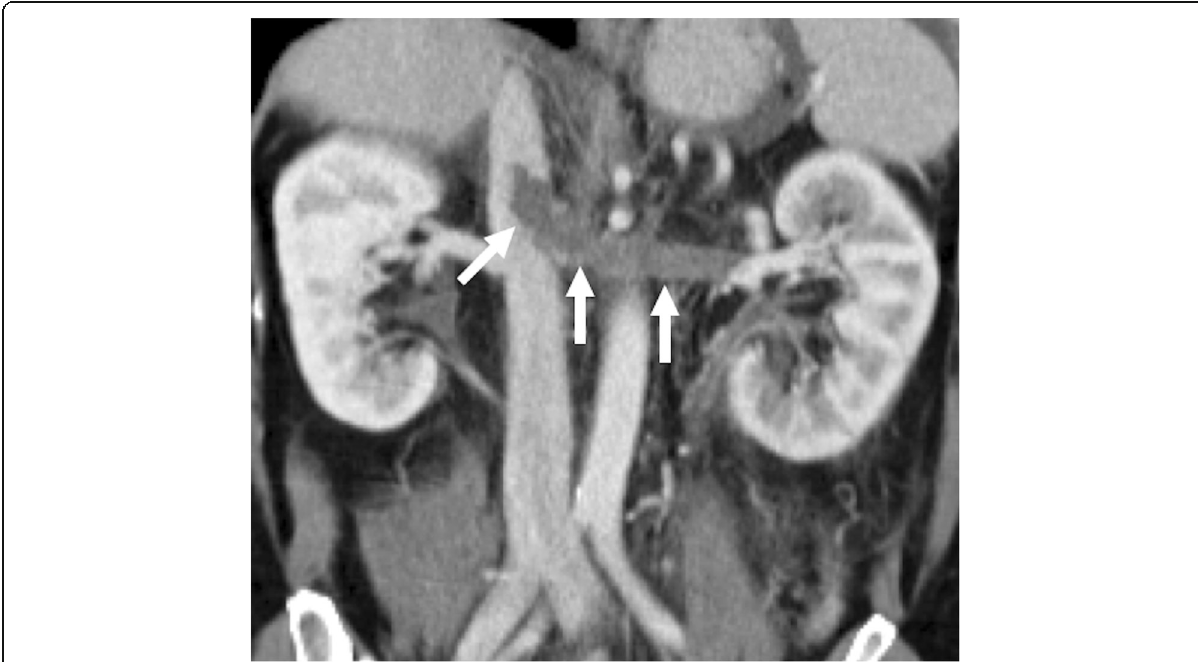
Fig. 18 Renal vein thrombosis. A 38-year-old woman with known antiphospholipid antibody syndrome (APS) presents to ED with severe left flank pain and gross hematuria. Coronally reformatted post-contrast CT image demonstrates a large thrombus (arrows) in the left renal vein with minimal extension into the